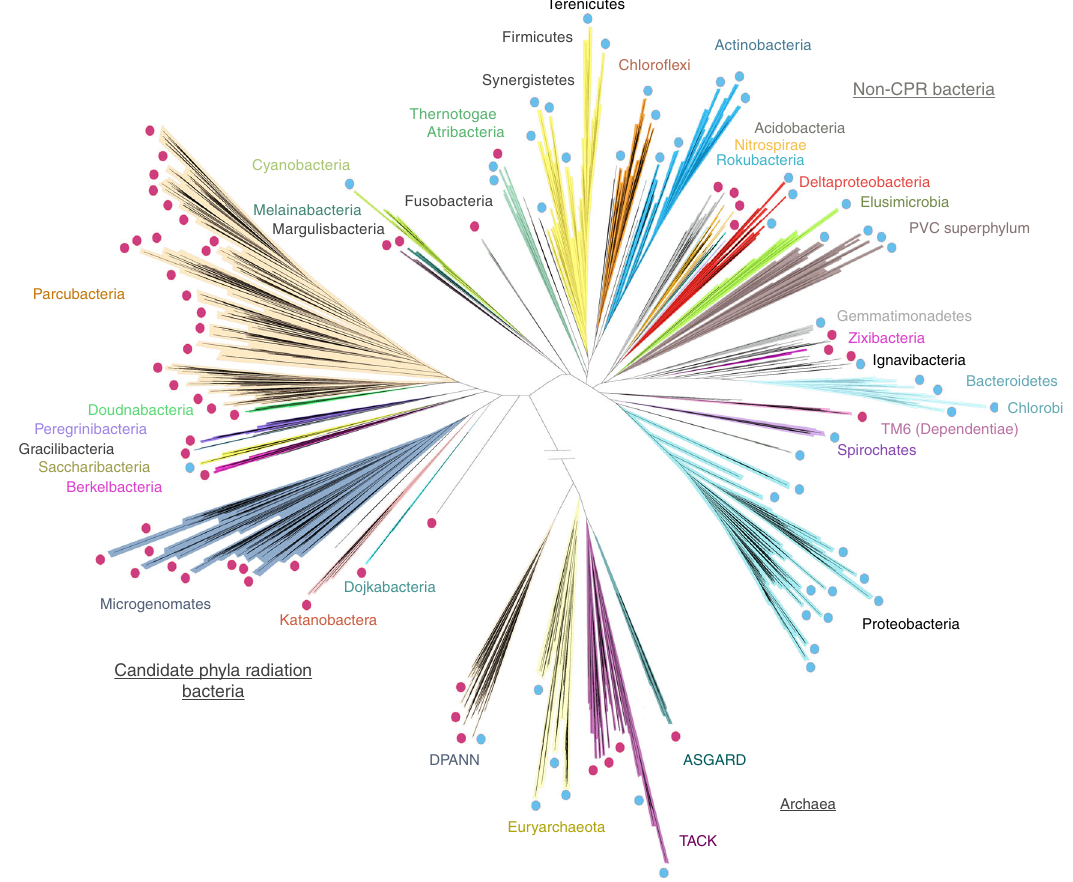
Fig. 1 Schematic tree illustrating the phylogenetic sampling used in this study. Lineages that were included in the datasets are highlighted with a dot. Lineages lacking an isolated representative are highlighted with red dots. The number of genomes per lineages is available in Supplementary Fig. 2. The diagram is based on a tree published recently in ref.